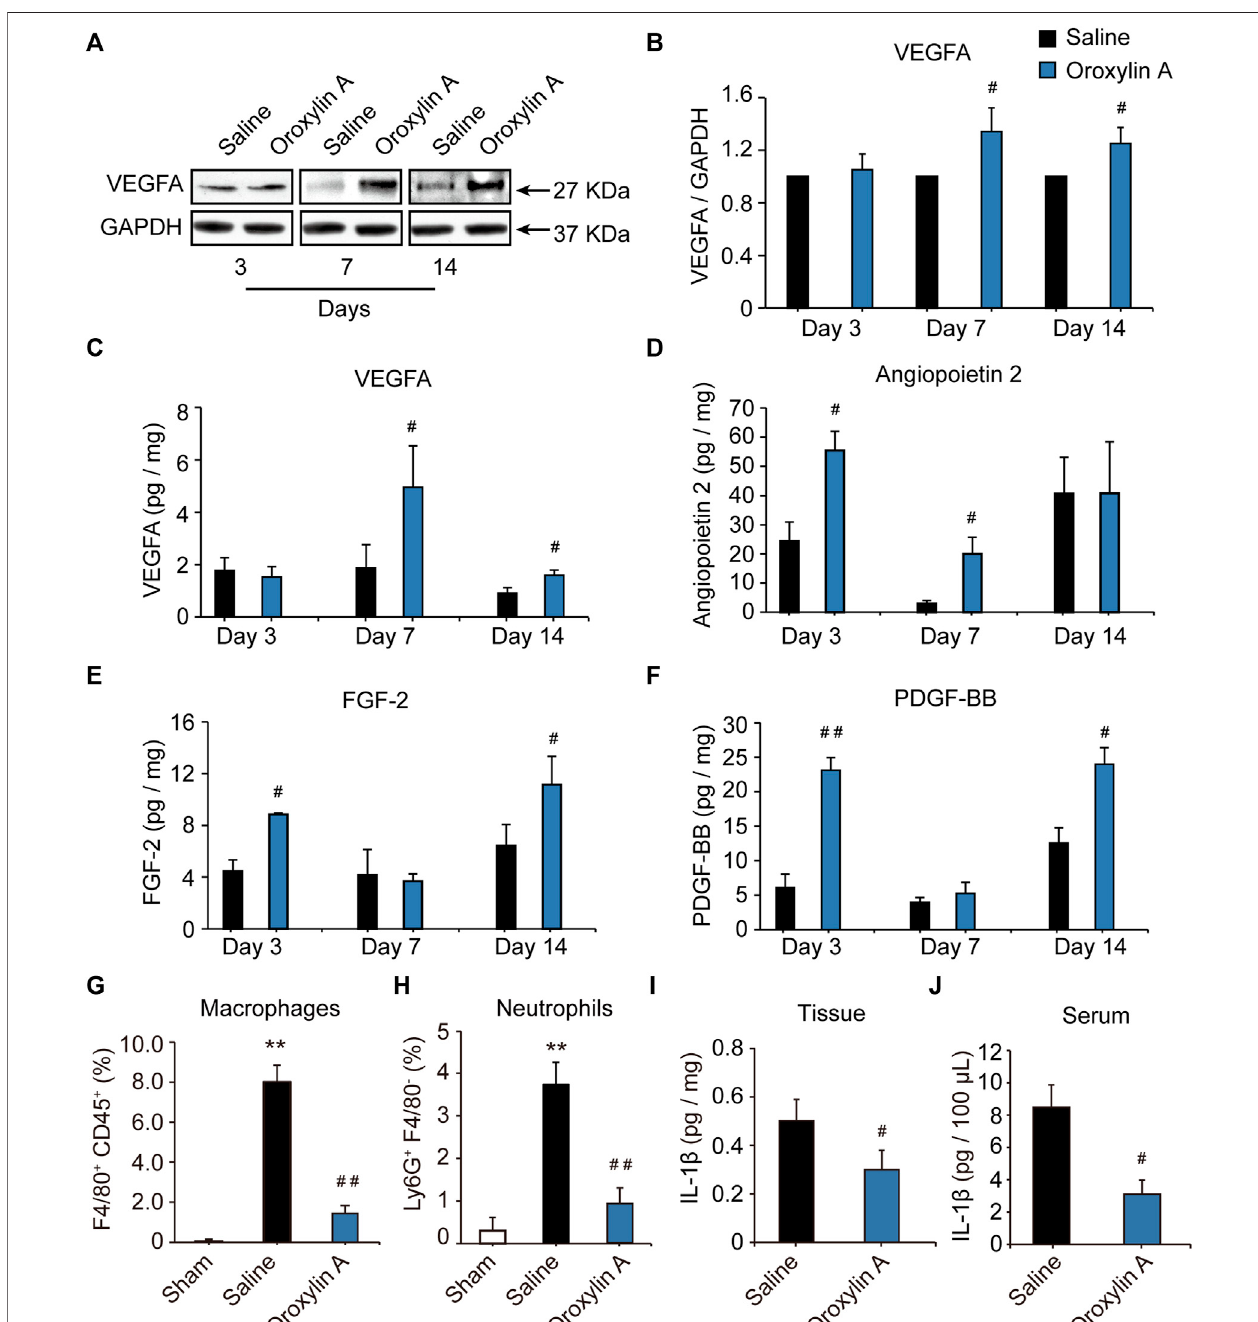
FIGURE 2 | OA regulated the secretion of VEGFA, ANG-2, FGF-2, and PDGF-BB at distinct time points during angiogenesis after HLI and resolved in fl ammation duringHLI.LysateswereimmunoblottedwithVEGFantibody,anddetectedwithanenhancedchemiluminescencekit.BlotswerenormalizedbydensitiesforGAPDHas aninternalcontrol (A,B) .QuantitativeVEGFA (C) ,ANG-2 (D) ,FGF-2 (E) ,andPDGF-BB (F) inischemictissueat3,7and14 daysafterHLIinthepresenceofOAorsaline weredetected byELISA.Values wererepresentedasmeans ± SD( n (cid:2) 3 – 4).Quanti fi cation by fl owcytometryofF4/80 + CD45 + macrophages (G) andLy6G + F4/80 - neutrophils (H) in skeletal muscle isolated from mice undergoing HLI (day 3) and treated with saline or OAwas presented. Tissue (I) and Serum (J) levels of IL-1 β in mice undergoing HLI and treated with saline or OA were detected. Data were represented as mean ± SD ( n (cid:2) 5). ** p < 0.01 vs . sham; # p < 0.05, ## p < 0.01 vs . saline.